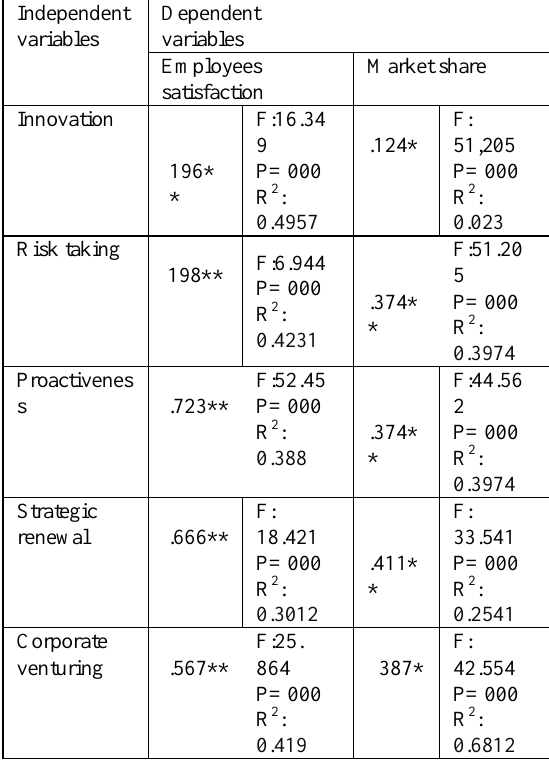
Table 1: Independent and Dependent